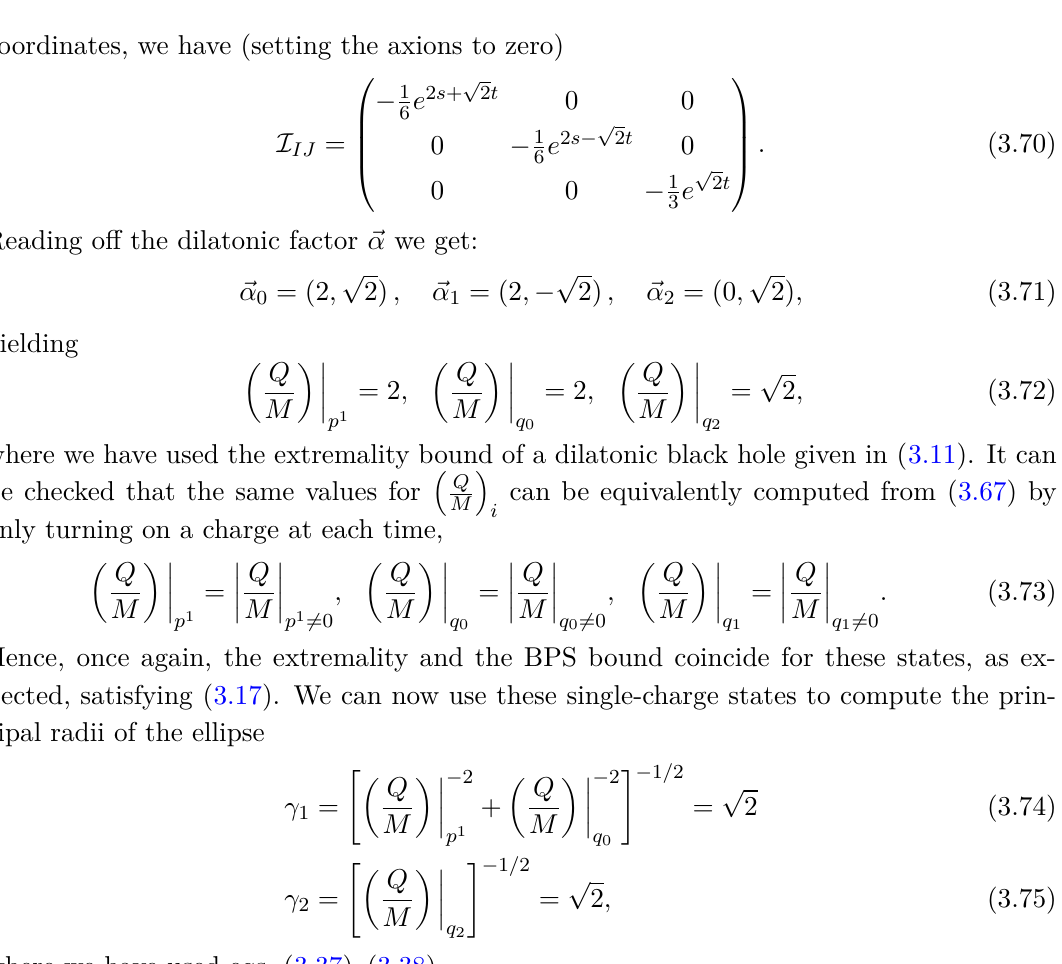
Figure 2. The charge-to-mass vectors for BPS states in a compactification with h 2 , 1 = 2 . The black line indicates the ellipse whose principal radii are given by eqs. (3.74) and (3.75), the red ellipses indicate the outer boundaries of the BPS region, and the green ellipses indicate the boundaries p 1 q 0 = 0 associated with the single-charge